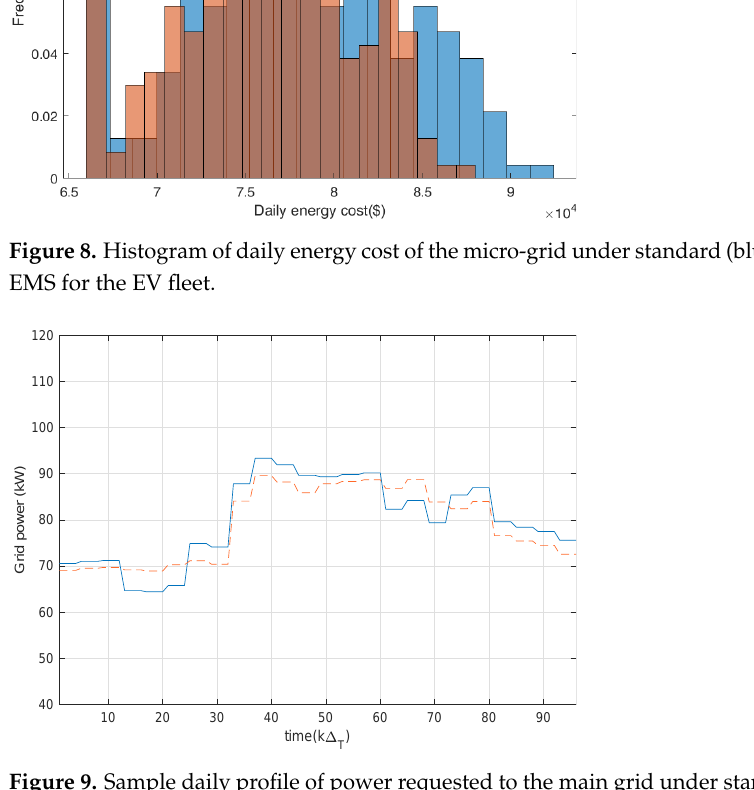
Figure 9. Sample daily profile of power requested to the main grid under standard (blue) and optima (orange) EMS for the EV